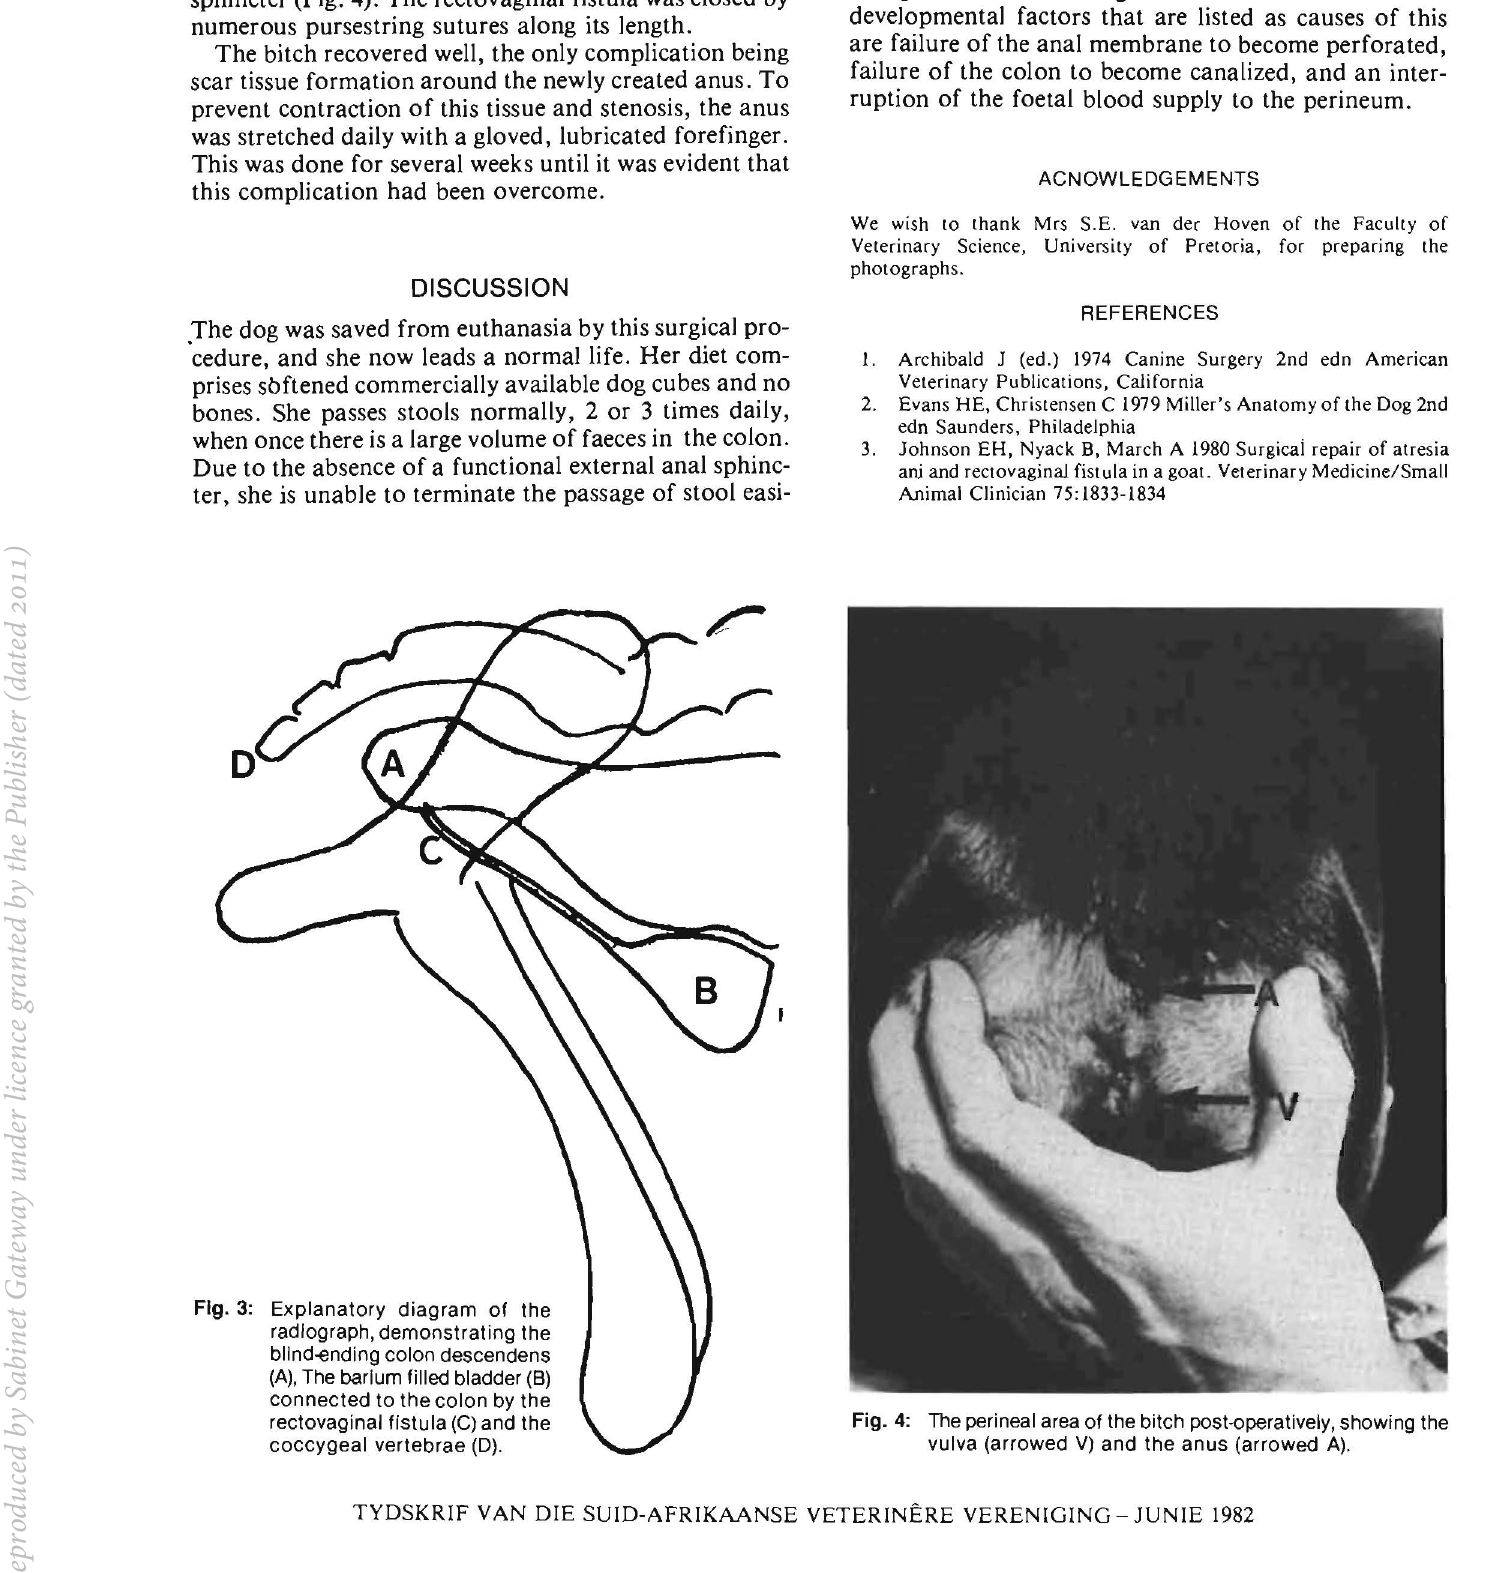
TYDSKRIF VAN DIE SUID-AFRIKAANSE VETERINERE VERENIGING - JUNIE